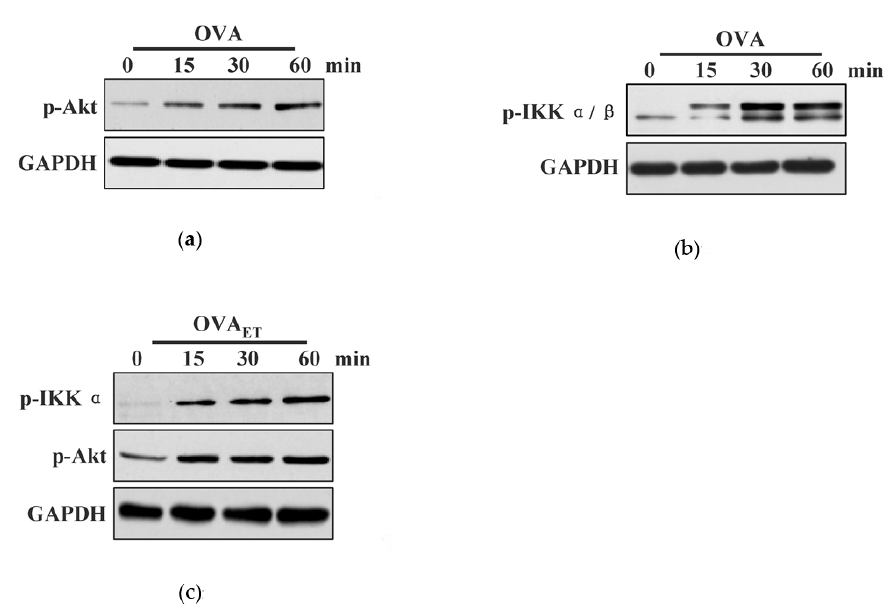
Figure 1. Endotoxin-containing pathogen and endotoxin-free antigen induce different effects on the phosphorylation of protein kinase B (Akt) and I-kappa B Kinase α (IKK α ) in bone marrow precursor cells. ( a – c ) Murine granulocyte-macrophage colony-stimulating factor (GM-CSF) and interleukin-4 (IL-4) treated bone marrow precursor cells (BMPC) was incubated with endotoxin-containing pathogen ovalbumin ( a , b ) or endotoxin-free ovalbumin ( c ) (50 µg/mL) for indicated periods. The effects of endotoxin-containing pathogen and endotoxin-free ovalbumin on the phosphorylation of Akt and IKK α / β were determined by western blot analyses. GAPDH was used as an internal control. One representative from 3 independent experiments is shown. OVA: endotoxin-containing pathogen ovalbumin; OVA ET : endotoxin-free ovalbumin.